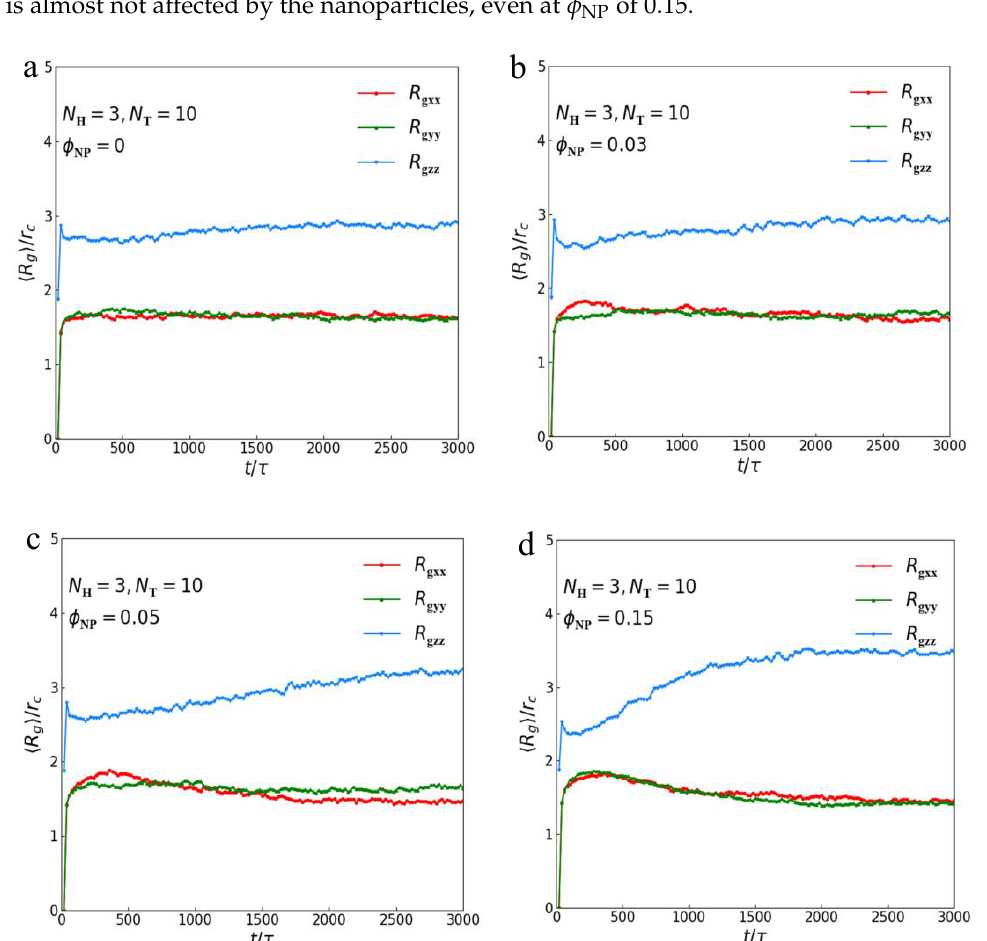
(cid:10) (cid:11) (cid:10) (cid:11) (cid:10) (cid:11) (cid:10) (cid:11) R gxx R gyy R gzz R g , and of at different concentrations of nanoparticles